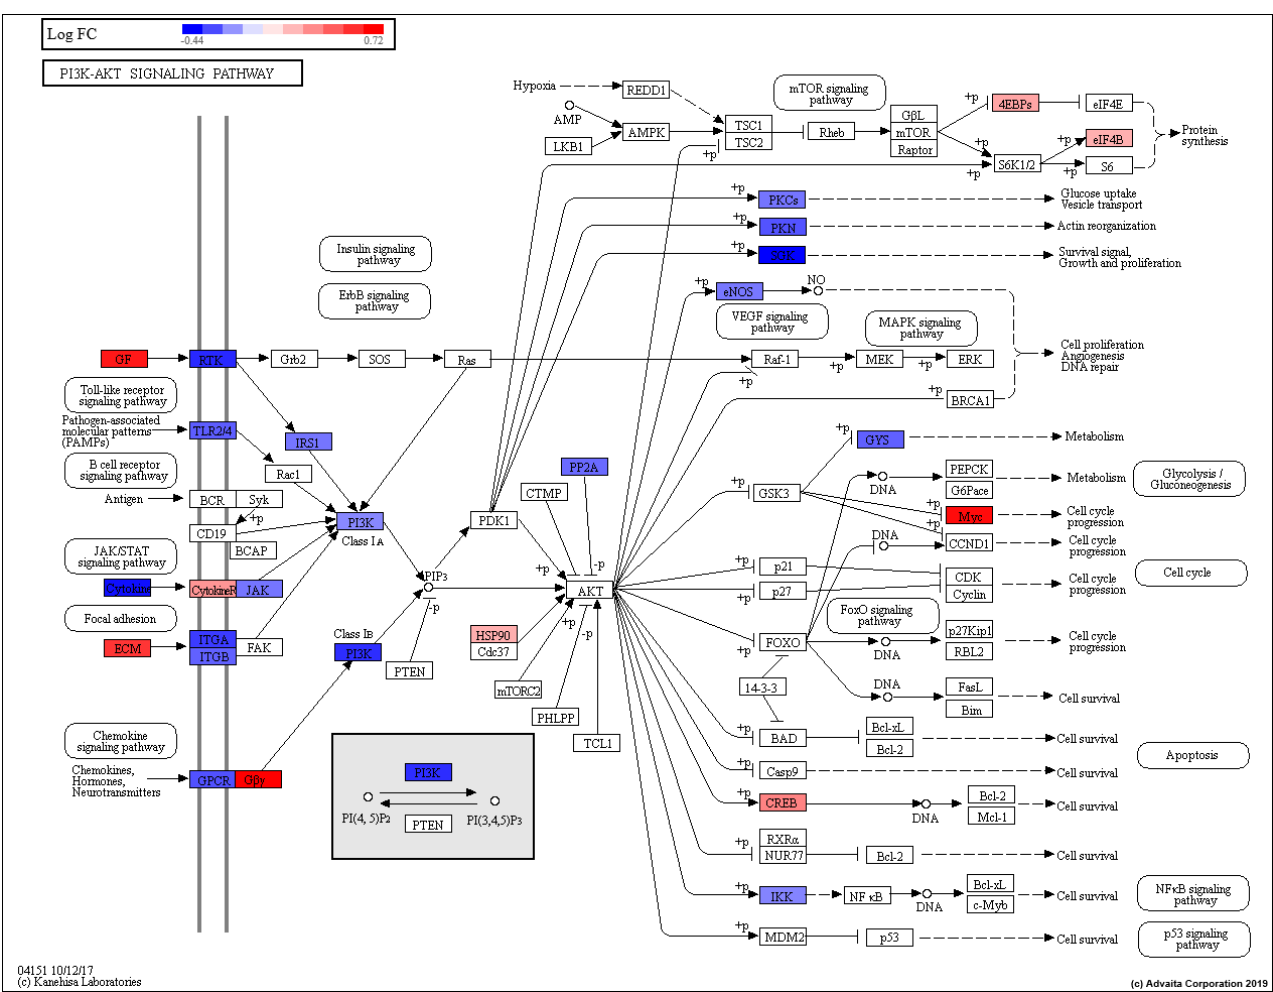
Figure 3. PI3K-Akt signaling pathway (KEGG: 04151) pathway genes showing gene regulation based on EA vs. AA prostate DE analysis (EA is control, AA is test). RED: upregulated, BLUE: downregulated.